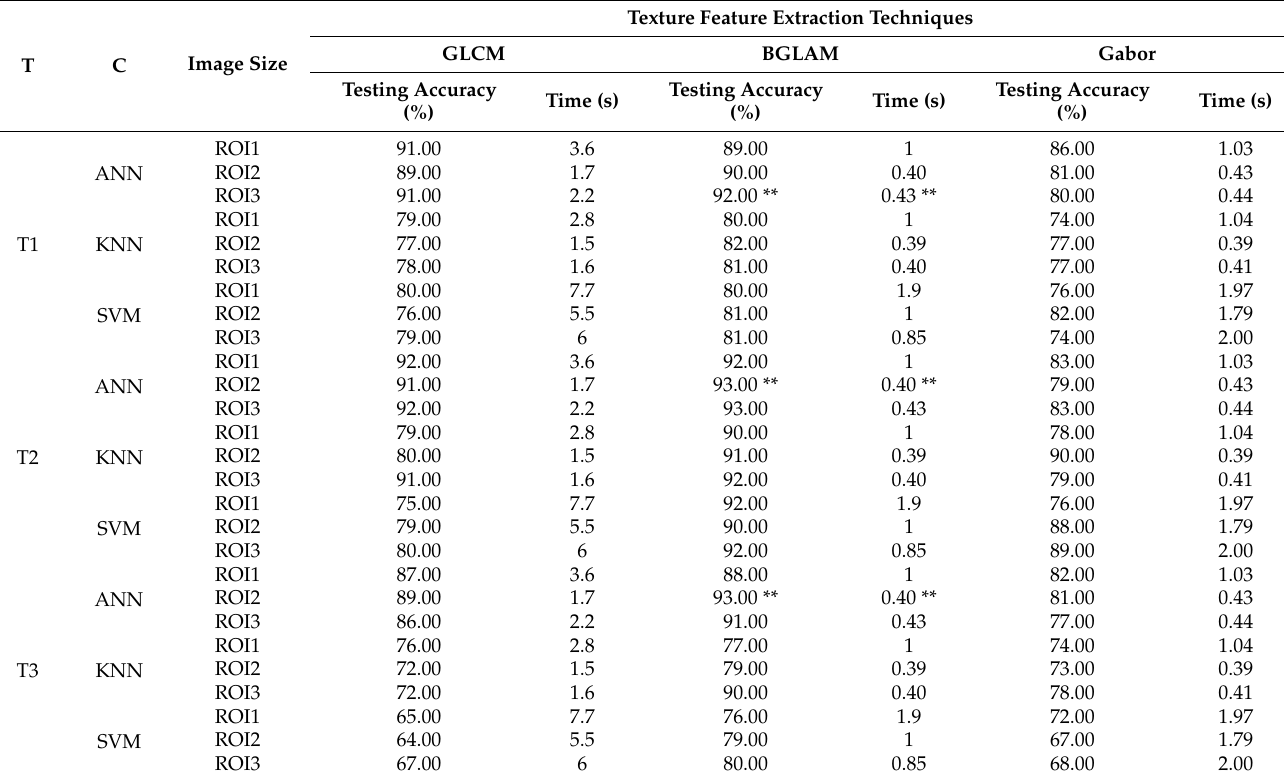
Table 7. Results of test computing FFB ripeness classification based on GLCM, GLAM and Gabor by using ANN, KNN and SVM.